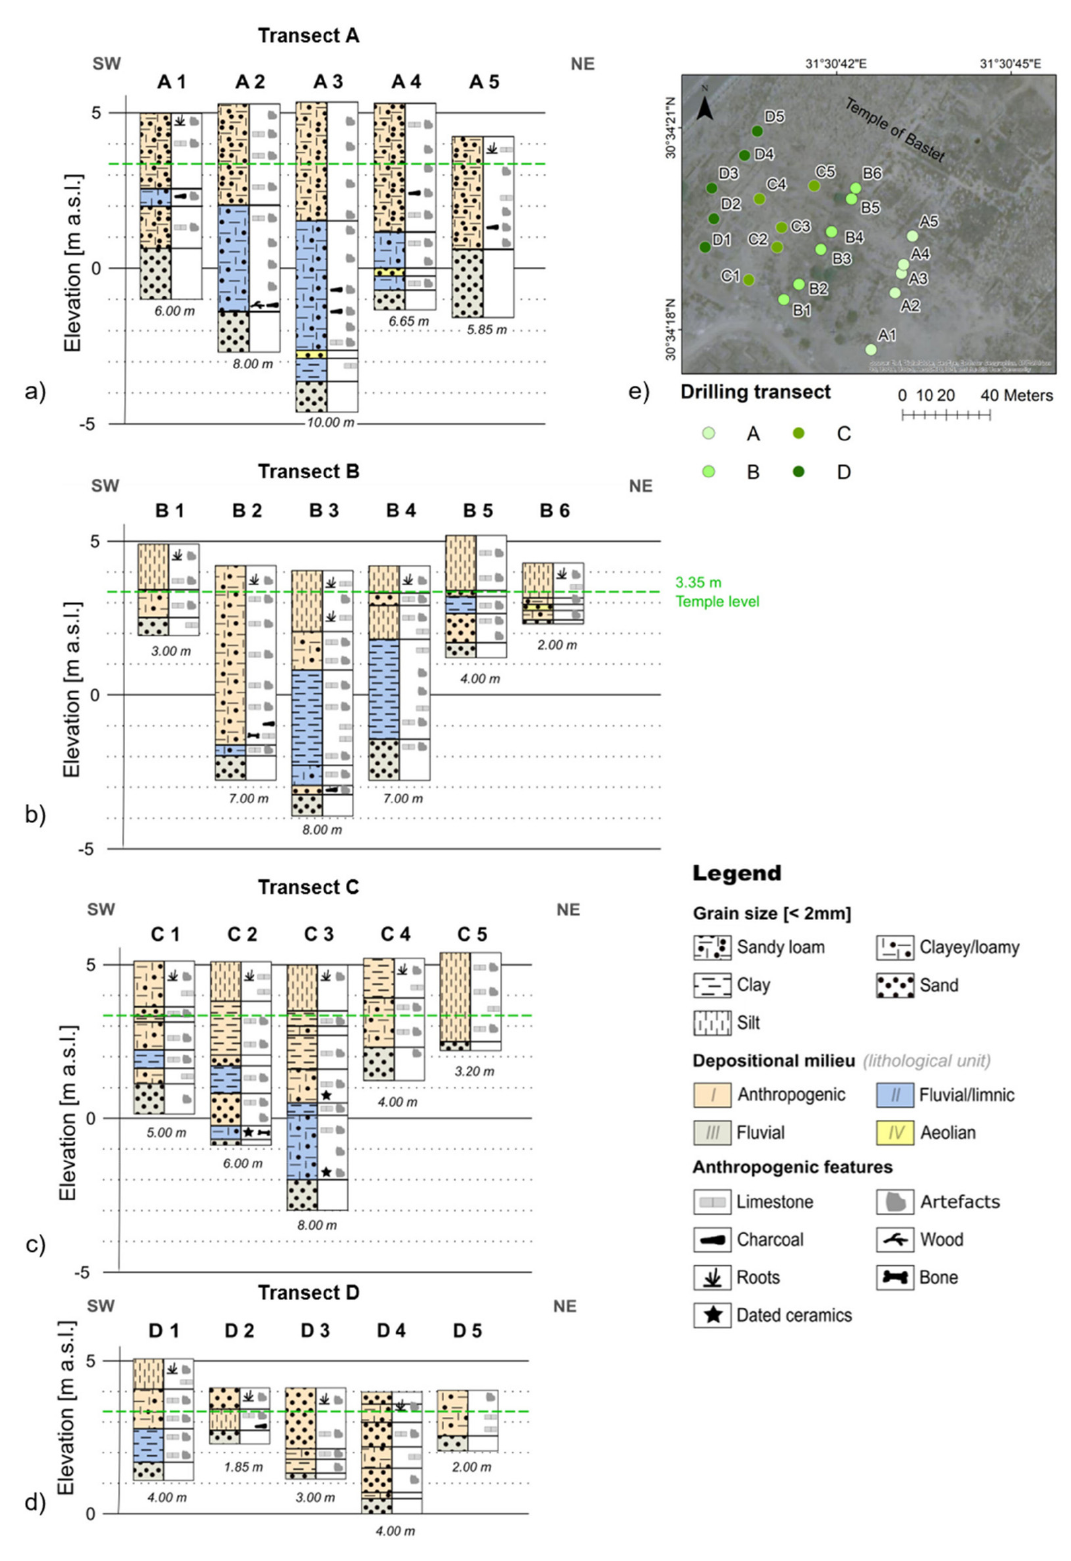
Figure 4. Drilling locations ( e ) and generalized results of drilling transects A–D in the south of the Temple of Bastet ( a – d ). The dashed green line marks the floor level of the Temple of Bastet in the 1st millennium BCE (3.35 m